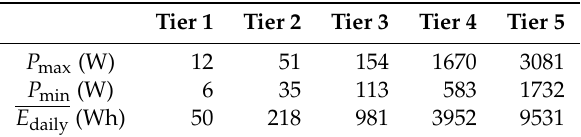
Table 2. Main load profile parameters based on the 1-year generated load profile: maximum ( P max ) and minimum peak power ( P min ), and average daily energy E daily for each tier